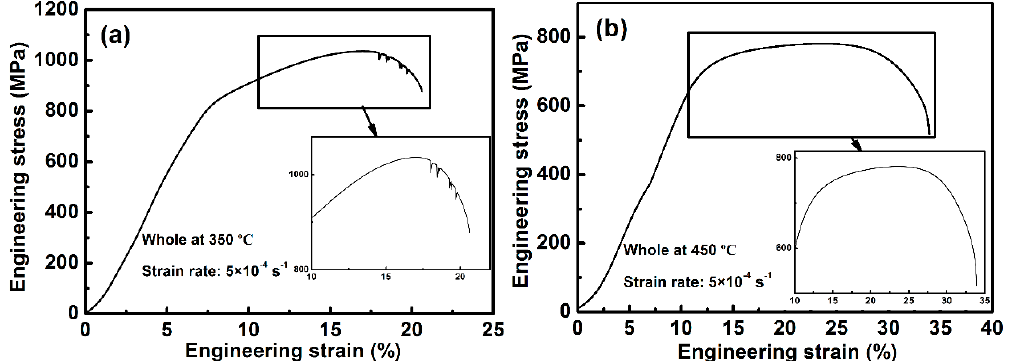
Figure 2. Tensile curve of the whole sample and partial enlarged detail at ( a ) 350 °C and ( b ) 450 °C.